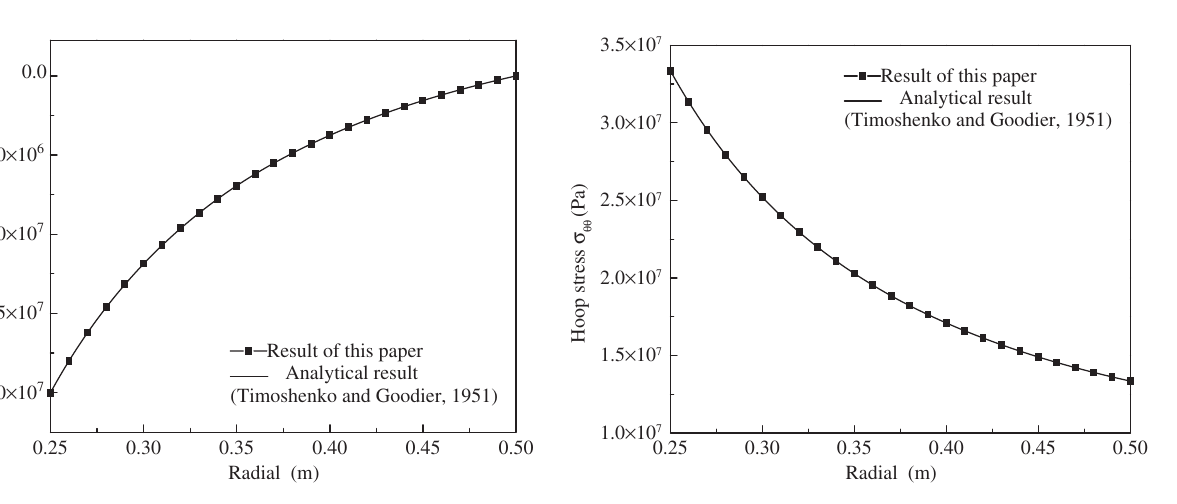
Figure 4 Distribution of hoop stress σ